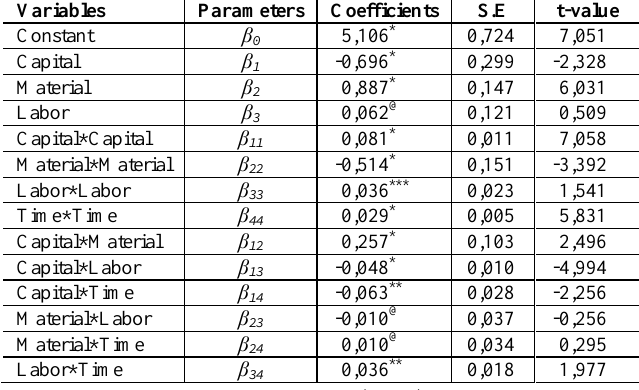
Table 3: Maximum-likelihood estimates of